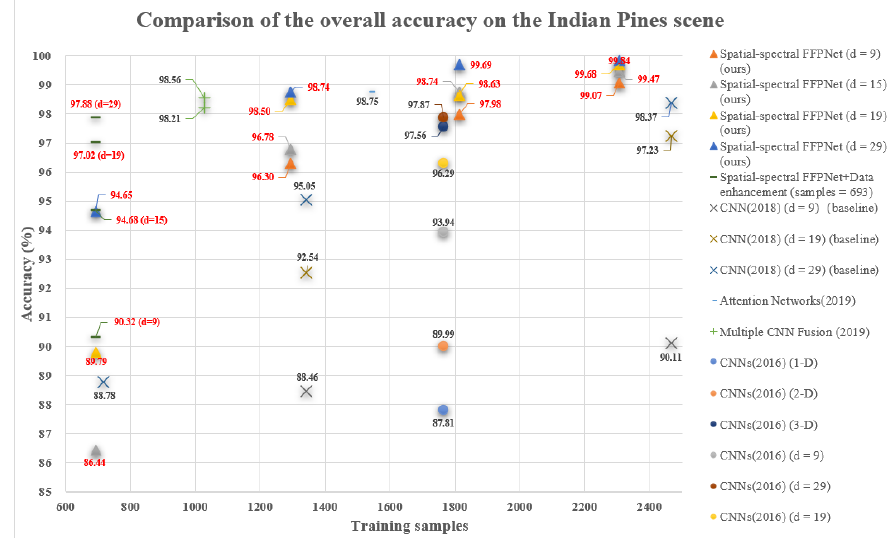
Figure 15. Comparison of the OA obtained by different CNN models for the IP dataset. The abscissa represents the total number of training samples (600–2500), and the ordinate represents the OA (%) of the CNN models. The figure mainly compares the accuracy of the existing CNN methods and the proposed spatial-spectral FFPNet under different training samples. In the legend, different shapes represent different methods for hyperspectral classification. In the same shape, different colors indicate different configurations of the same method. The OA results obtained by our proposed model is presented in red, and those obtained by other CNNs [41], CNN [40], attention networks [45], and multiple CNN fusion [42] are presented in